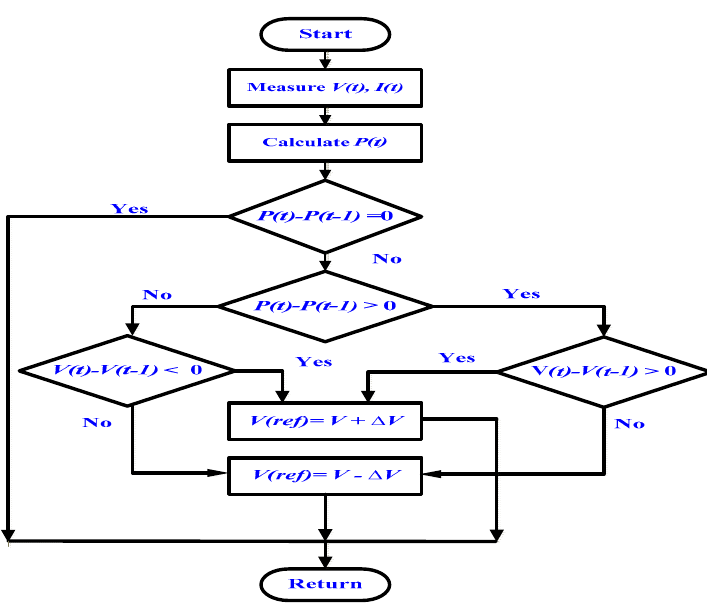
Figure 7. The flow chart of Perturb and Observe (P&O) technique.